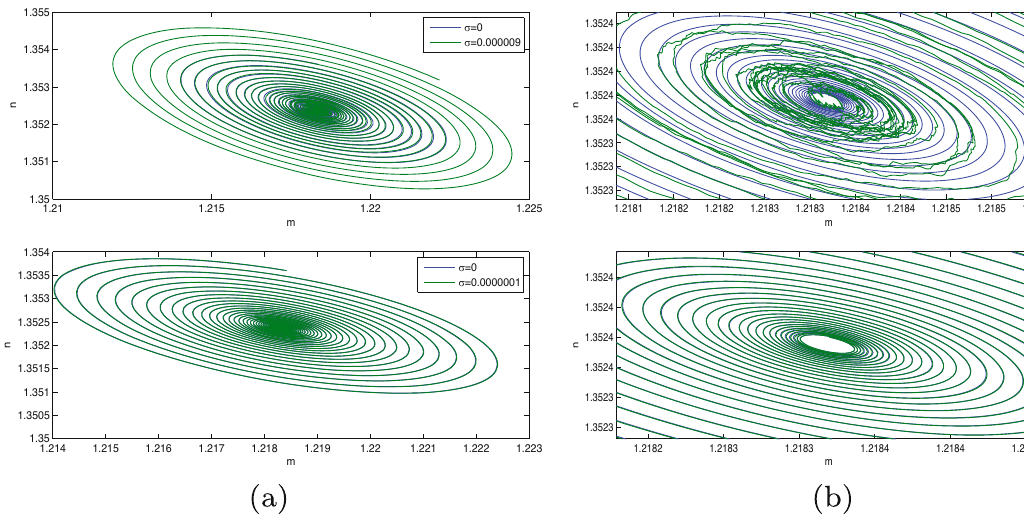
Figure 6: ( a ) The phase portraits with noise of di ff erent intensity and ( b ) the partial enlarged drawing of Figure 6 ( a )